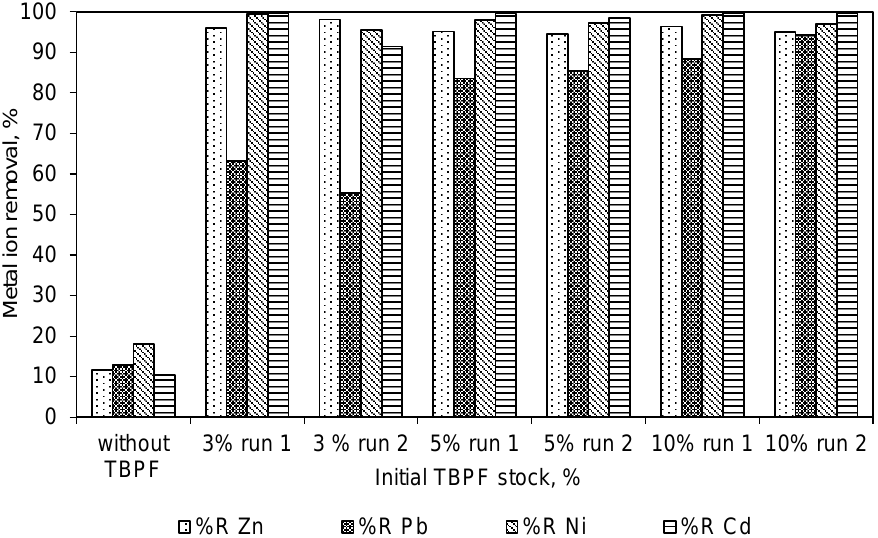
Figure 3. Effect of initial concentration of TBPF (3%, 5%, and 10%) on metal ion removal (Zn, Pb, Ni, and Cd) at pH 10 in a 2.0 mg/L metal ion concentration.